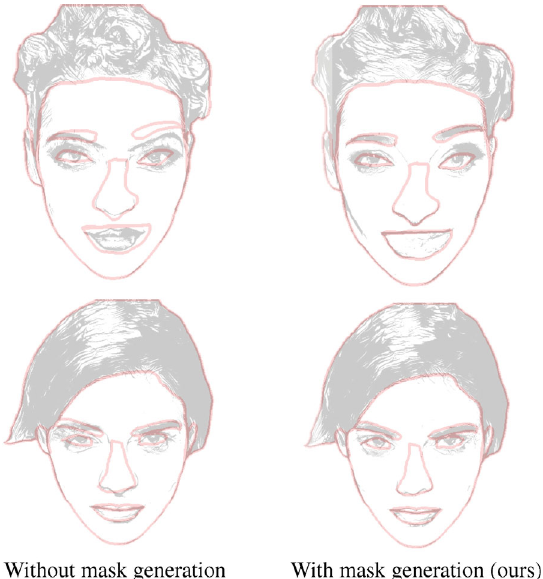
Fig. 8 Results with and without the mask generation process. Mismatches are obvious between the user’s contour sketch (red lines) and the generated local guidance without mask generation (left).